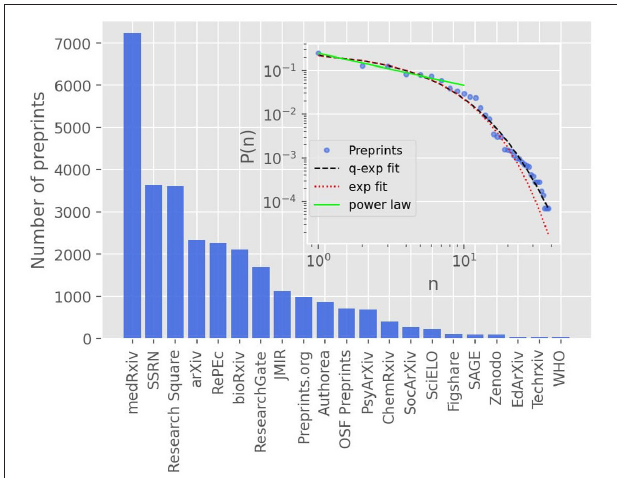
FIGURE 3 | The main plot shows the ranking of the largest preprint repositories by number of COVID-19 related preprints, including all repositories with at least 40 preprints, up to September, 30, 2020. The inset shows the complete rank-frequency distribution in log-log scale, where the red dotted line is an exponential fit, P ( n ) ∝ exp( − α n ), with α = 0.25 ± 0.02; the black dashed line is a fit with the q -exponential function, P ( n ) ∝ exp q ( − β n ), where q = 1.05 and β = 0.27 ± 0.02. The solid green line is a power-law fit, P ( n ) ∝ n − ρ , to the first seventh largest repositories, which yields the exponent ρ = 0.73 ±